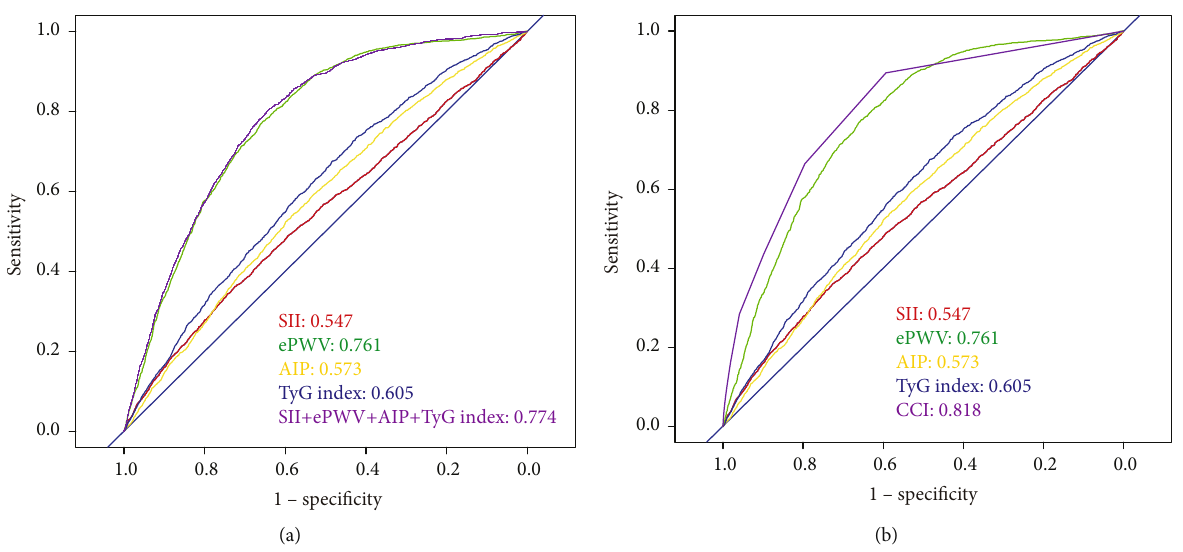
Figure 4: ROC curve analysis was used to test the predictive ability of (a) SII index, ePWV, AIP, and TyG index and their combinations and (b) SII index, ePWV, AIP, TyG index, and CCI index to CVD. Abbreviation: SII: systemic immune in fl ammation; ePWV: estimated pulse wave velocity; AIP: atherogenic index of plasma; TyG: triglyceride-glucose; CVD: cardiovascular